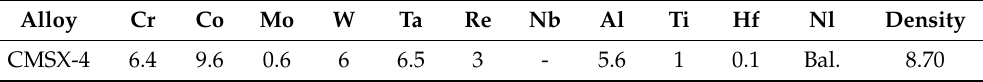
Table 1. The Chemical composition of CMSX-4 ® (wt